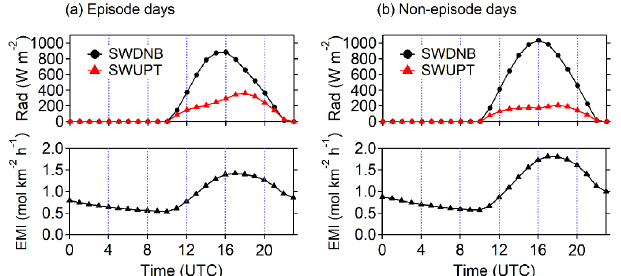
Figure A13. The diurnal variation of radiation flux (upward shortwave radiation at the top of the atmosphere (SWUPT) and downward shortwave radiation at the surface (SWDNB)) and α -pinene emission rate (EMI) for the average of (a) upper troposphere biogenic SOA episode days and (b) non-episode